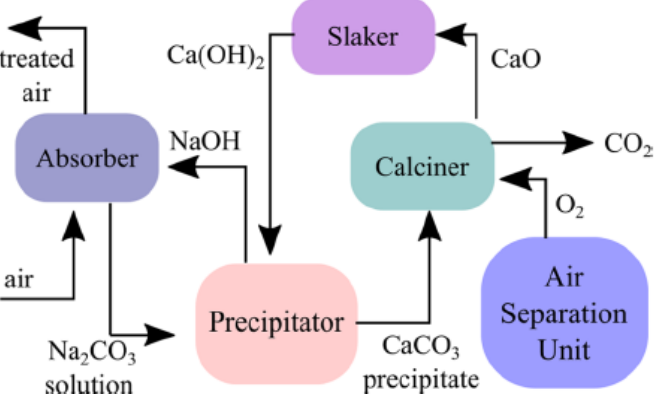
Figure 3. Process scheme for the DAC absorption process with NaOH aqueous solution. Reproduced under the Standard ACS AuthorChoice/Editors’ Choice Usage Agreement [18] .